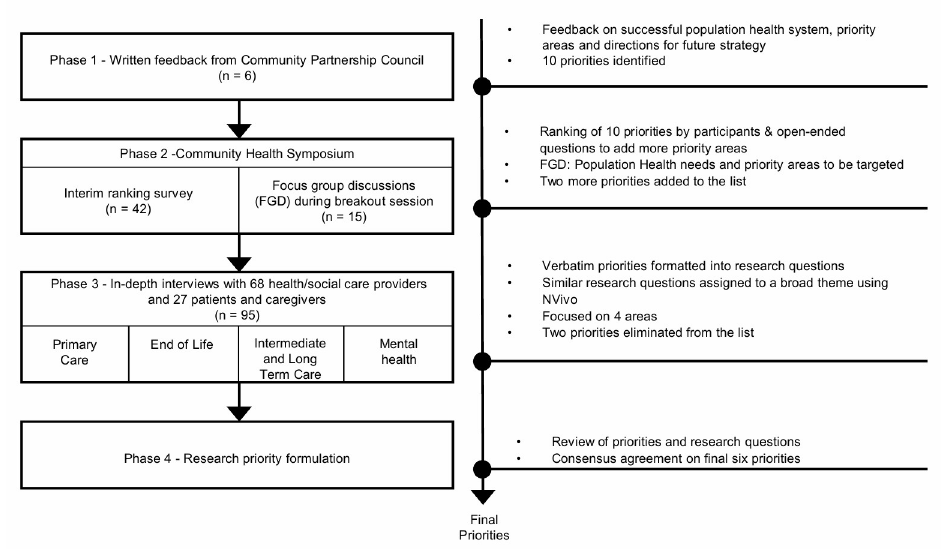
Fig 1. Summary of